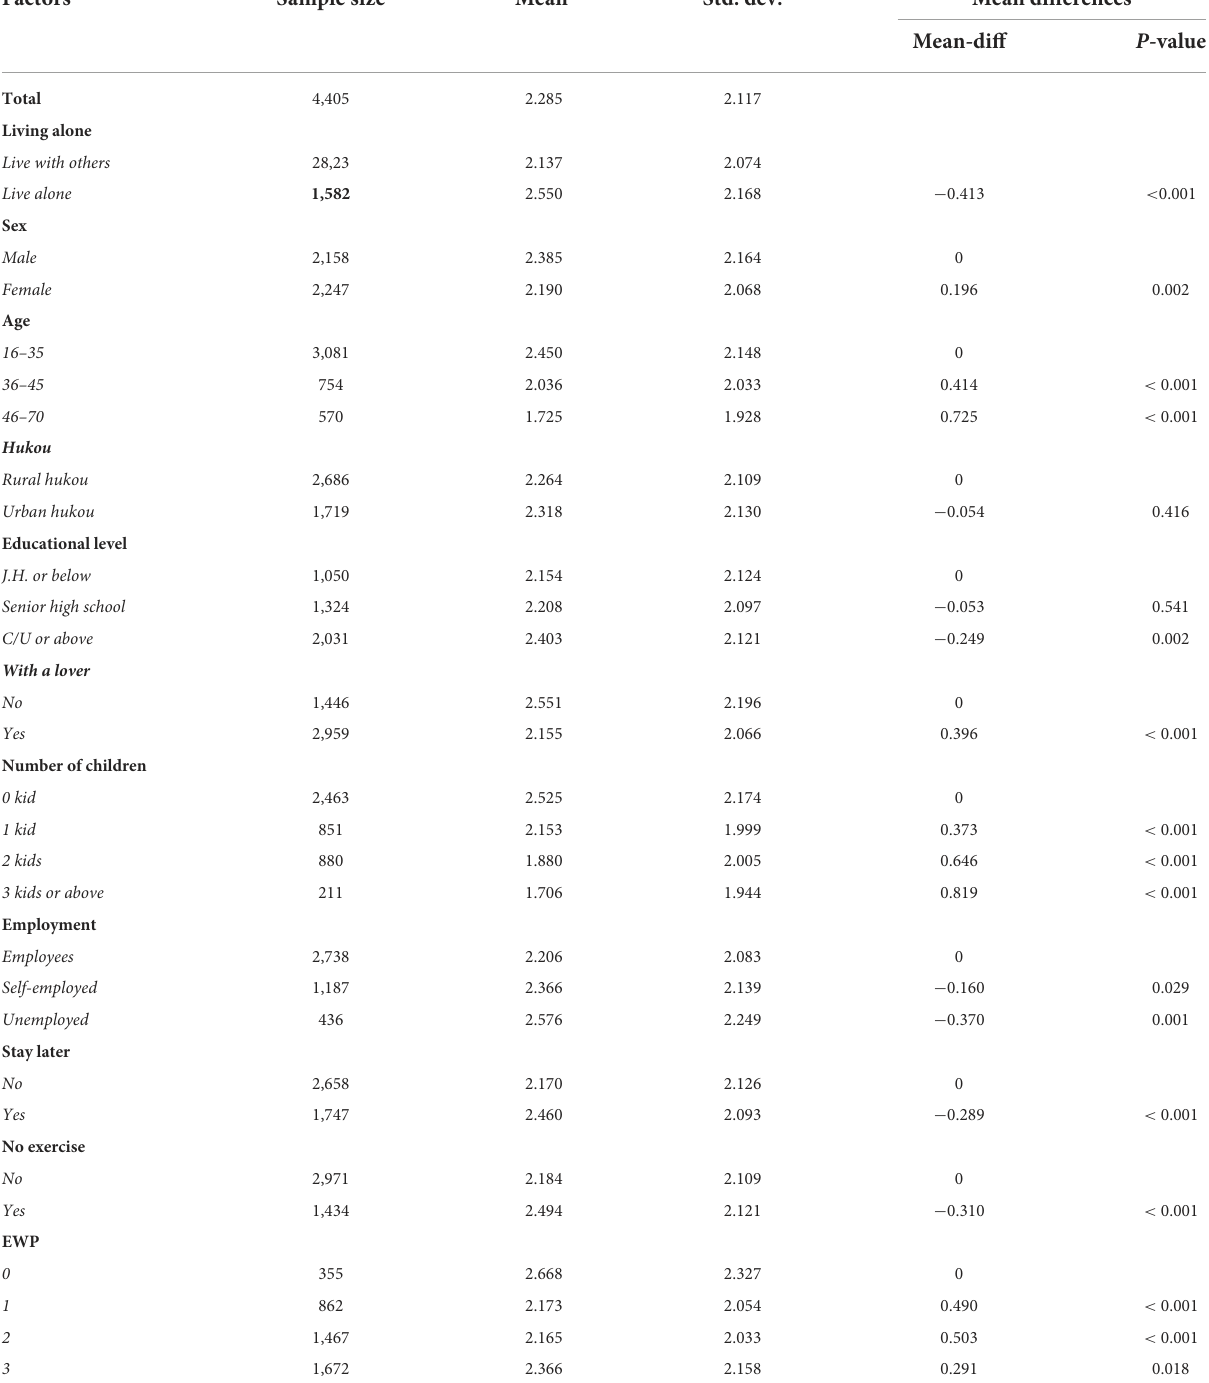
TABLE 1 The GHQ-12 mental health scores for each personal information and lifestyle factor. Factors Sample size Mean Std. dev. Mean differences